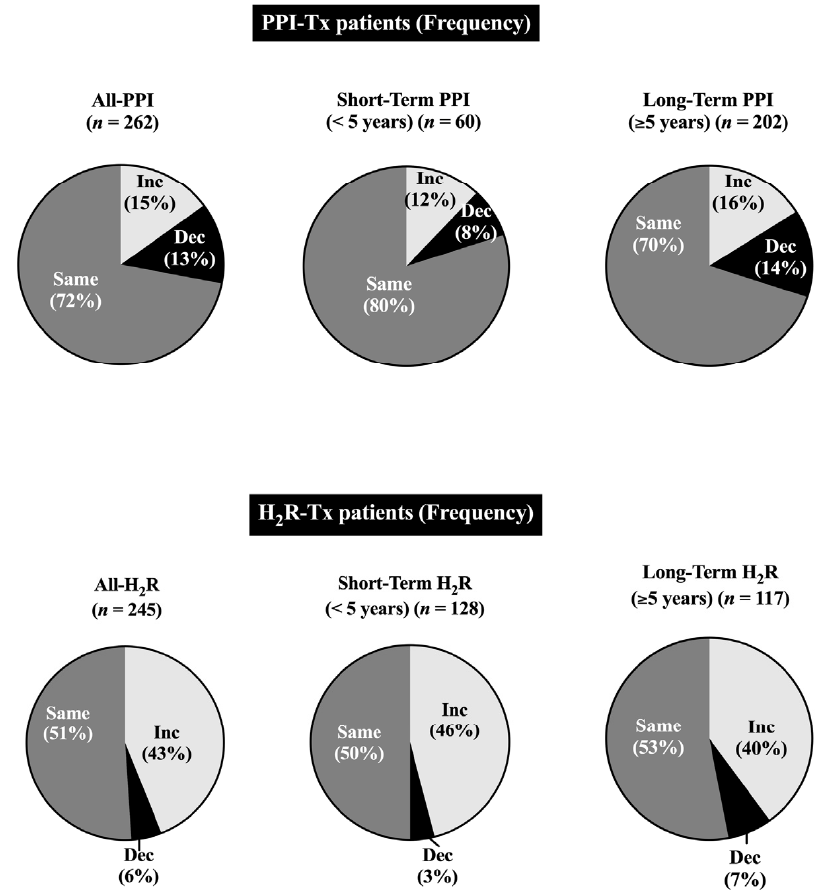
Figure 4. Pie charts showing distribution of changes in total drug daily dose in patients who had an increased frequency of dosing with short- or long-term treatment with either a histamine H 2 -receptor antagonist or proton pump inhibitor. Data shows the percentage of ZES patients having an increased daily dosing frequency treated with either a histamine H 2 -receptor antagonist or proton pump inhibitors at any time, during short-term (<5 yrs) or long-term ( ≥ 5 yrs) treatment, which resulted in an increase in total daily drug frequency, no total daily dose change, or had a decrease in total daily drug dose, determined as described in the Section 2. The duration between the first and last daily doses used for comparing daily dosing frequency were the same as listed for the daily dose comparison in the legend of Figure